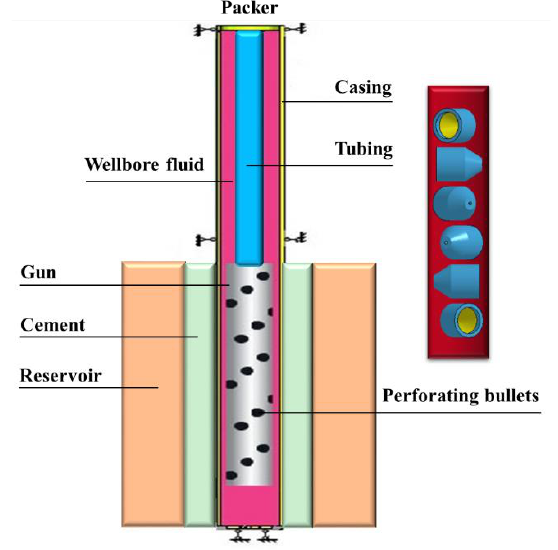
Figure 3. 3D physical model.